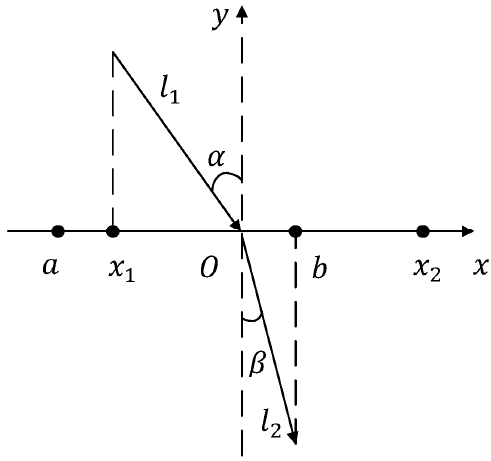
Figure 4. ROBL Mechanism.